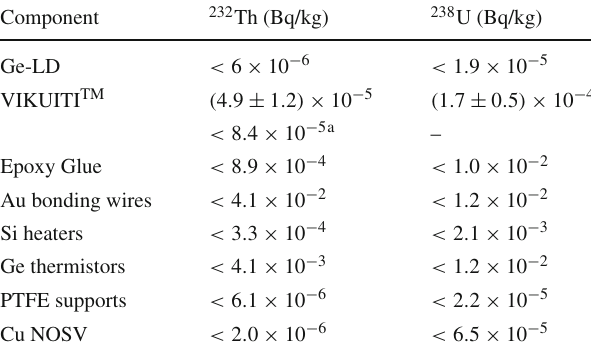
Table 1 Measurements and limits on contaminations of CUPID-0 detector components. Ge-LD radiopurity is certified by